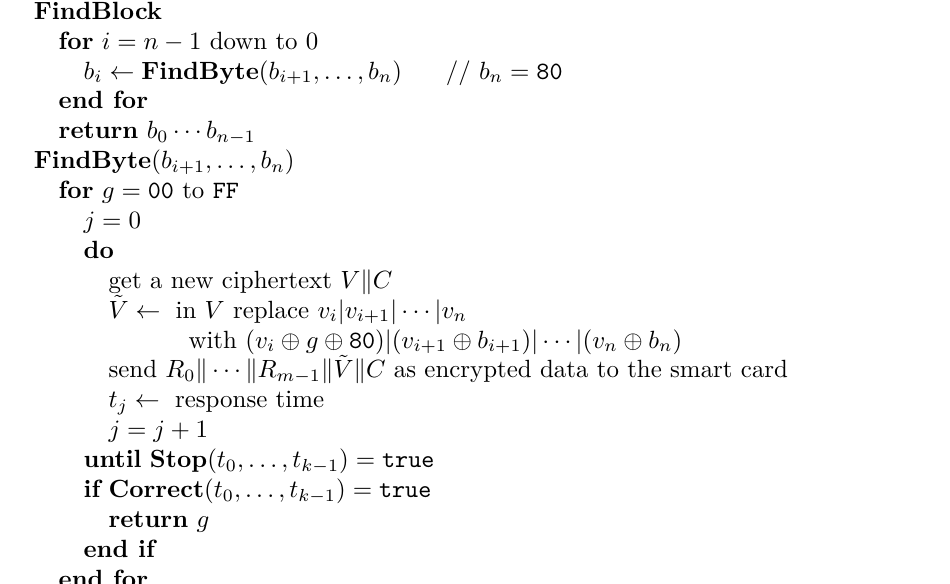
Algorithm 2: Padding oracle attack based on the card response time